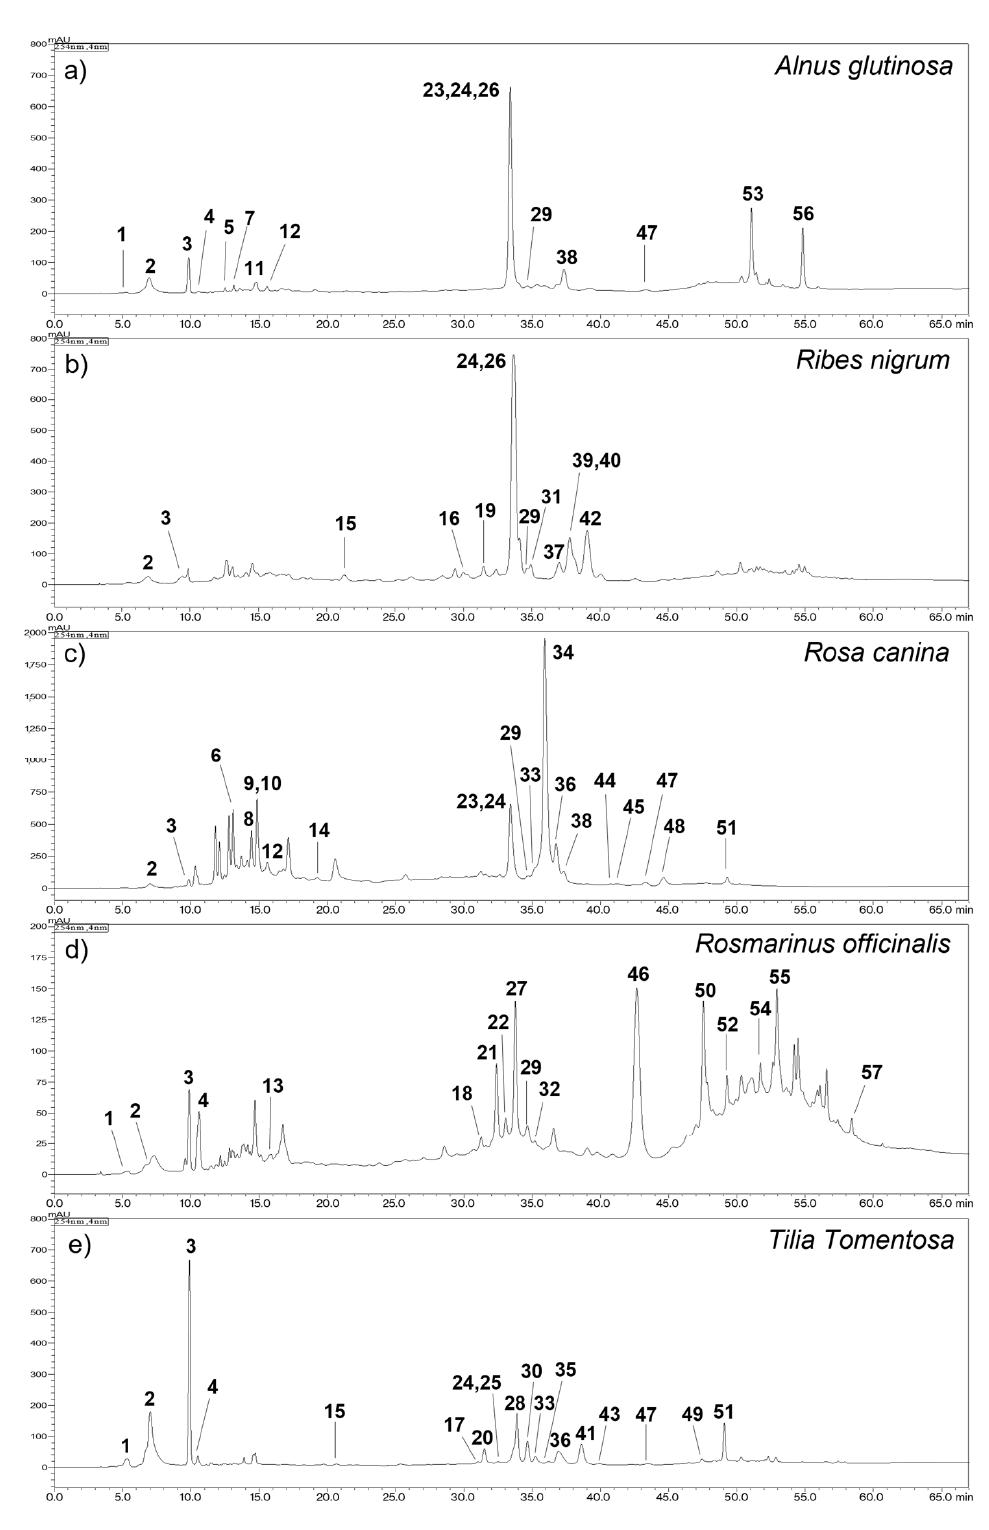
Figure 2. HPLC-DAD profiles of ( a ) Alnus glutinosa , ( b ) Ribes nigrum , ( c ) Rosa canina , ( d )